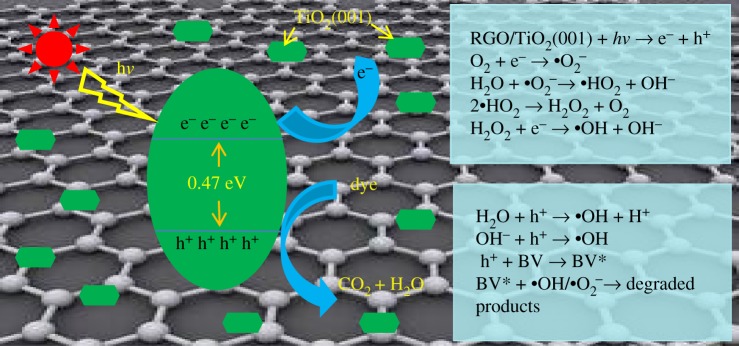
Illustration of photocatalytic process on RGO/TiO2 (001).